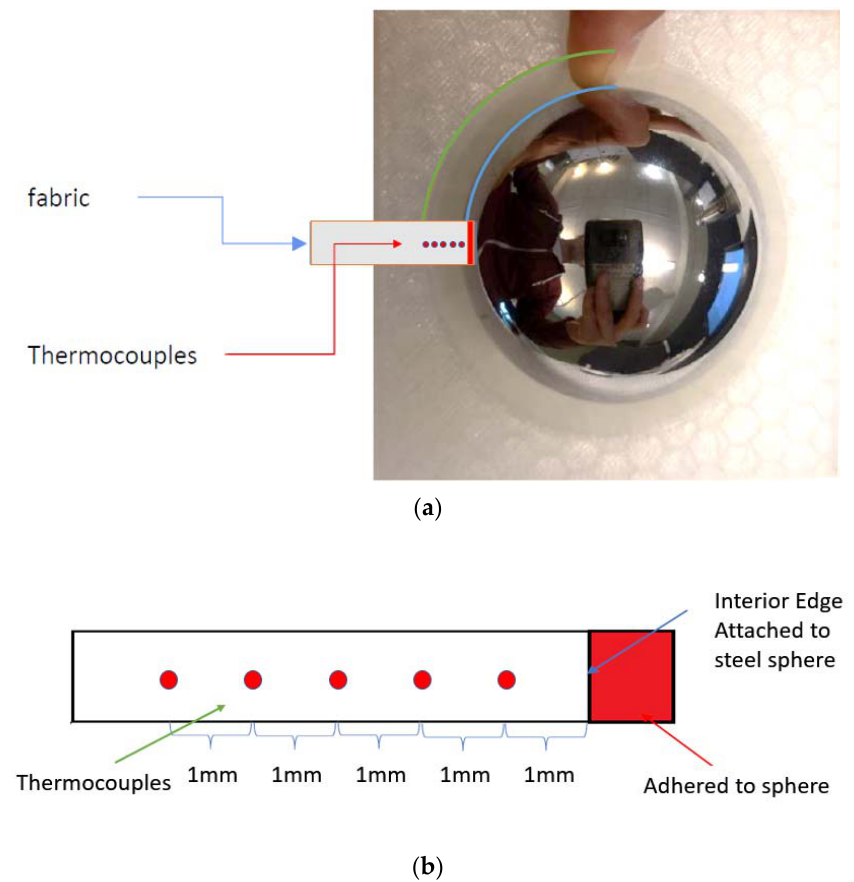
Figure 4. Position of the thermocouples in reference to the sample geometry: ( a ) View of the rubber mold, steel sphere, fabric and thermocouple placement location; ( b ) Detail view of thermocouple placement on fabric.